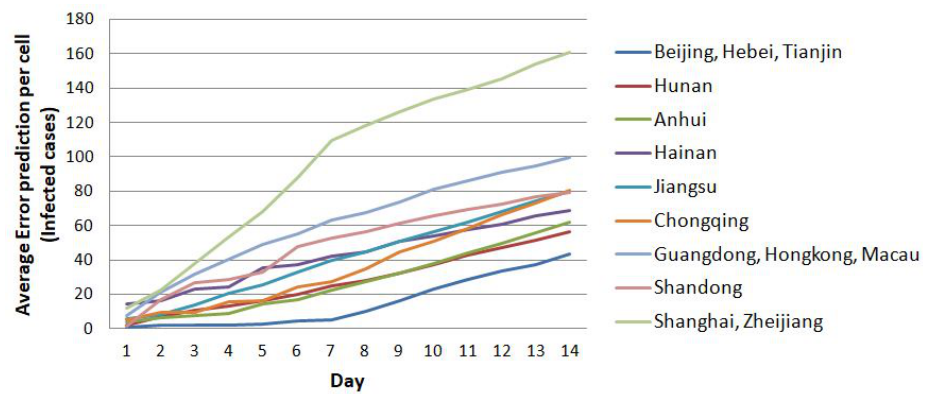
Figure 17. The trend of prediction error to about 160 cases per cell until the 14th